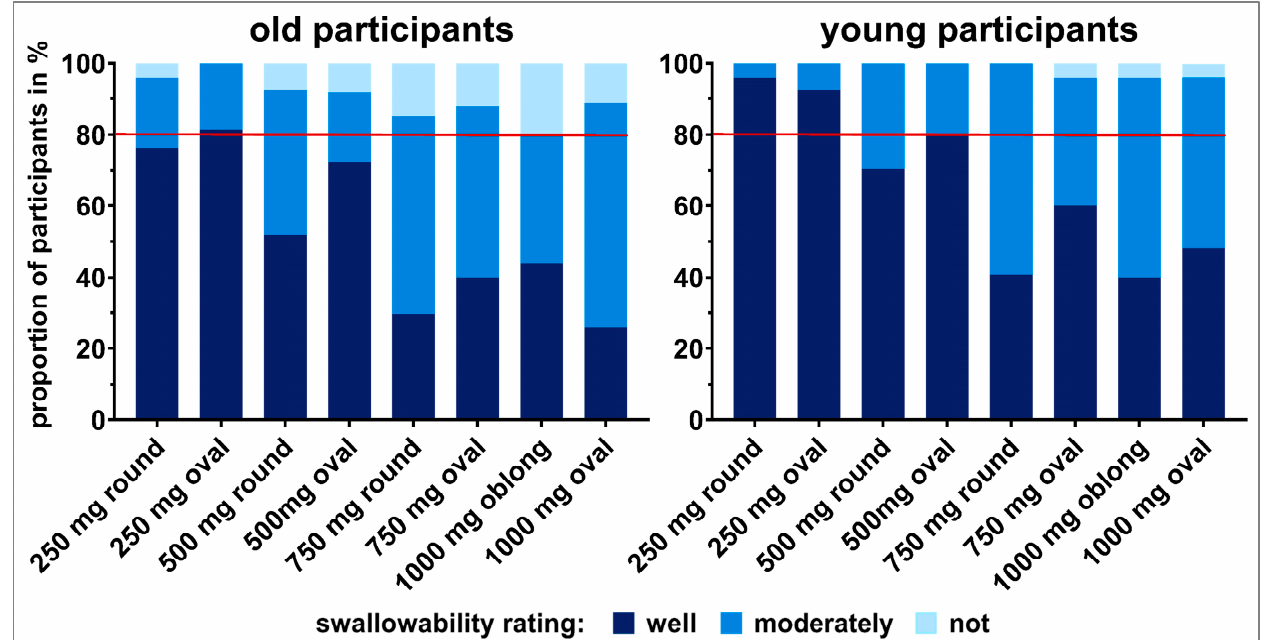
Figure 3. Summary of swallowability ratings ( not swallowable , moderately swallowable , and well swallowable) for each of the tablets tested in old and young participants. The rating of each participant comprises the swallowability evaluations of three study days. Taking the ratings not and moderately swallowable together and comparing those to the ratings well swallowable allows for a strict qualitative swallowability assessment. However, when taking the two ratings well and moderately swallowable together and comparing to the rating not swallowable , swallowability capabilities can be evaluated. The red line represents 80% of participants.